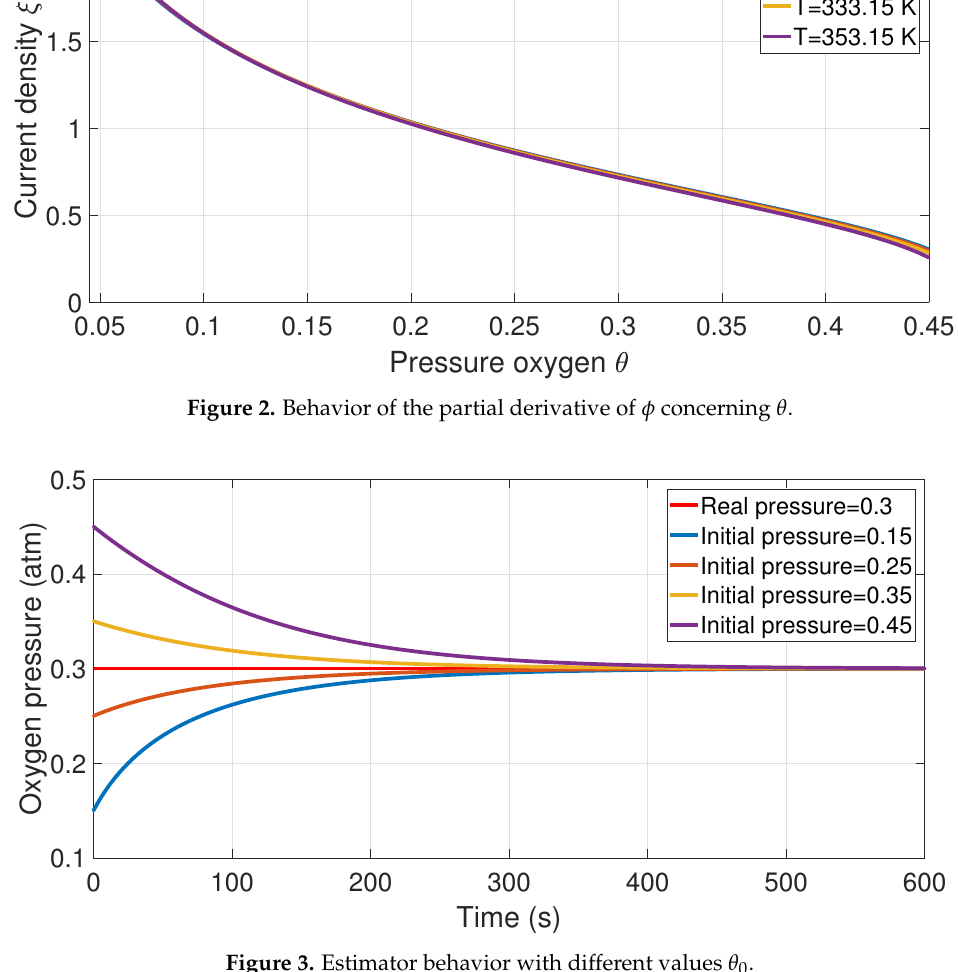
Figure 3. Estimator behavior with different values θ 0 .